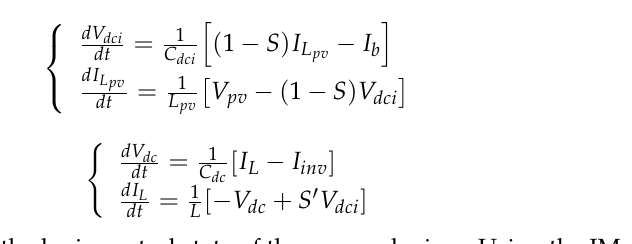
Figure 3. Boost-buck converter.